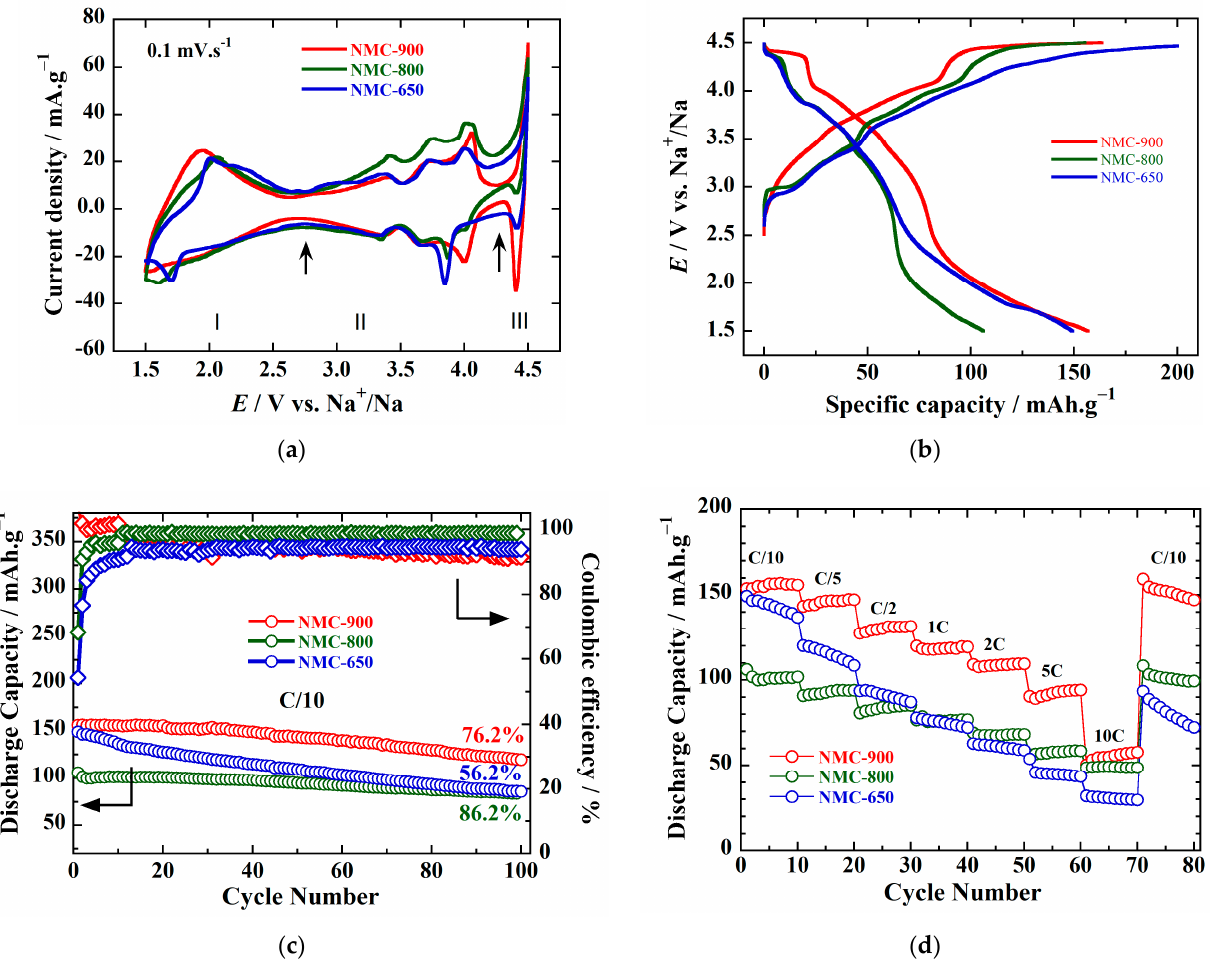
Figure 4. ( a ) Cyclic voltammogram of NMC materials in 1.5–4.5 V voltage windows at a scan rate of 100 µV·s − 1 . ( b ) The fi rst charge–discharge voltage pro fi les, ( c ) evolution of capacity and